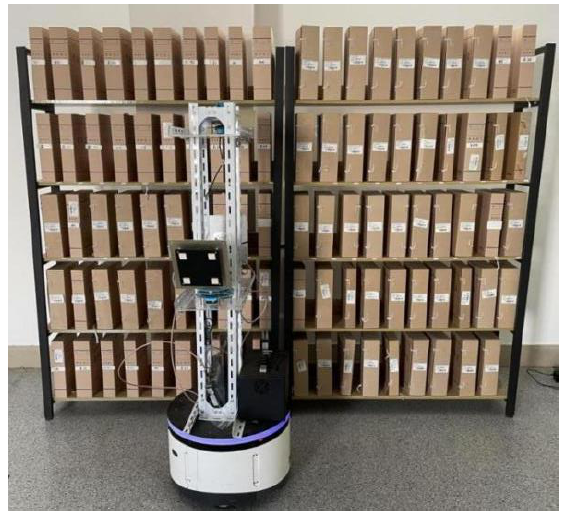
Figure 8. Experimental scene. Table 1. Experimental devices.